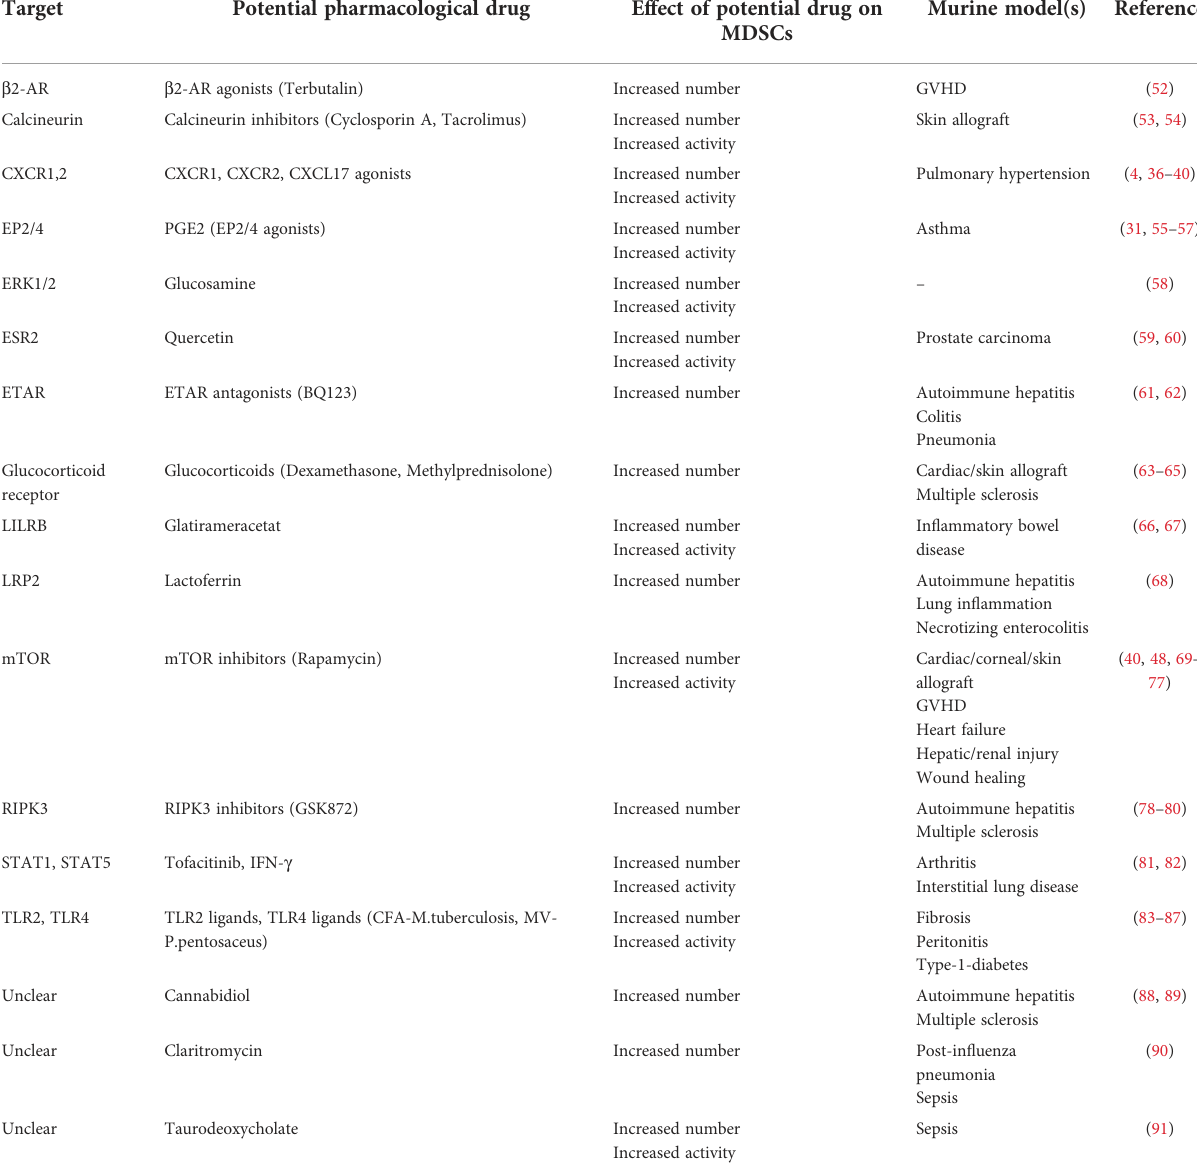
TABLE 1 Potential pharmacological targets and drugs to modulate MDSCs to dampen in fl ammation.